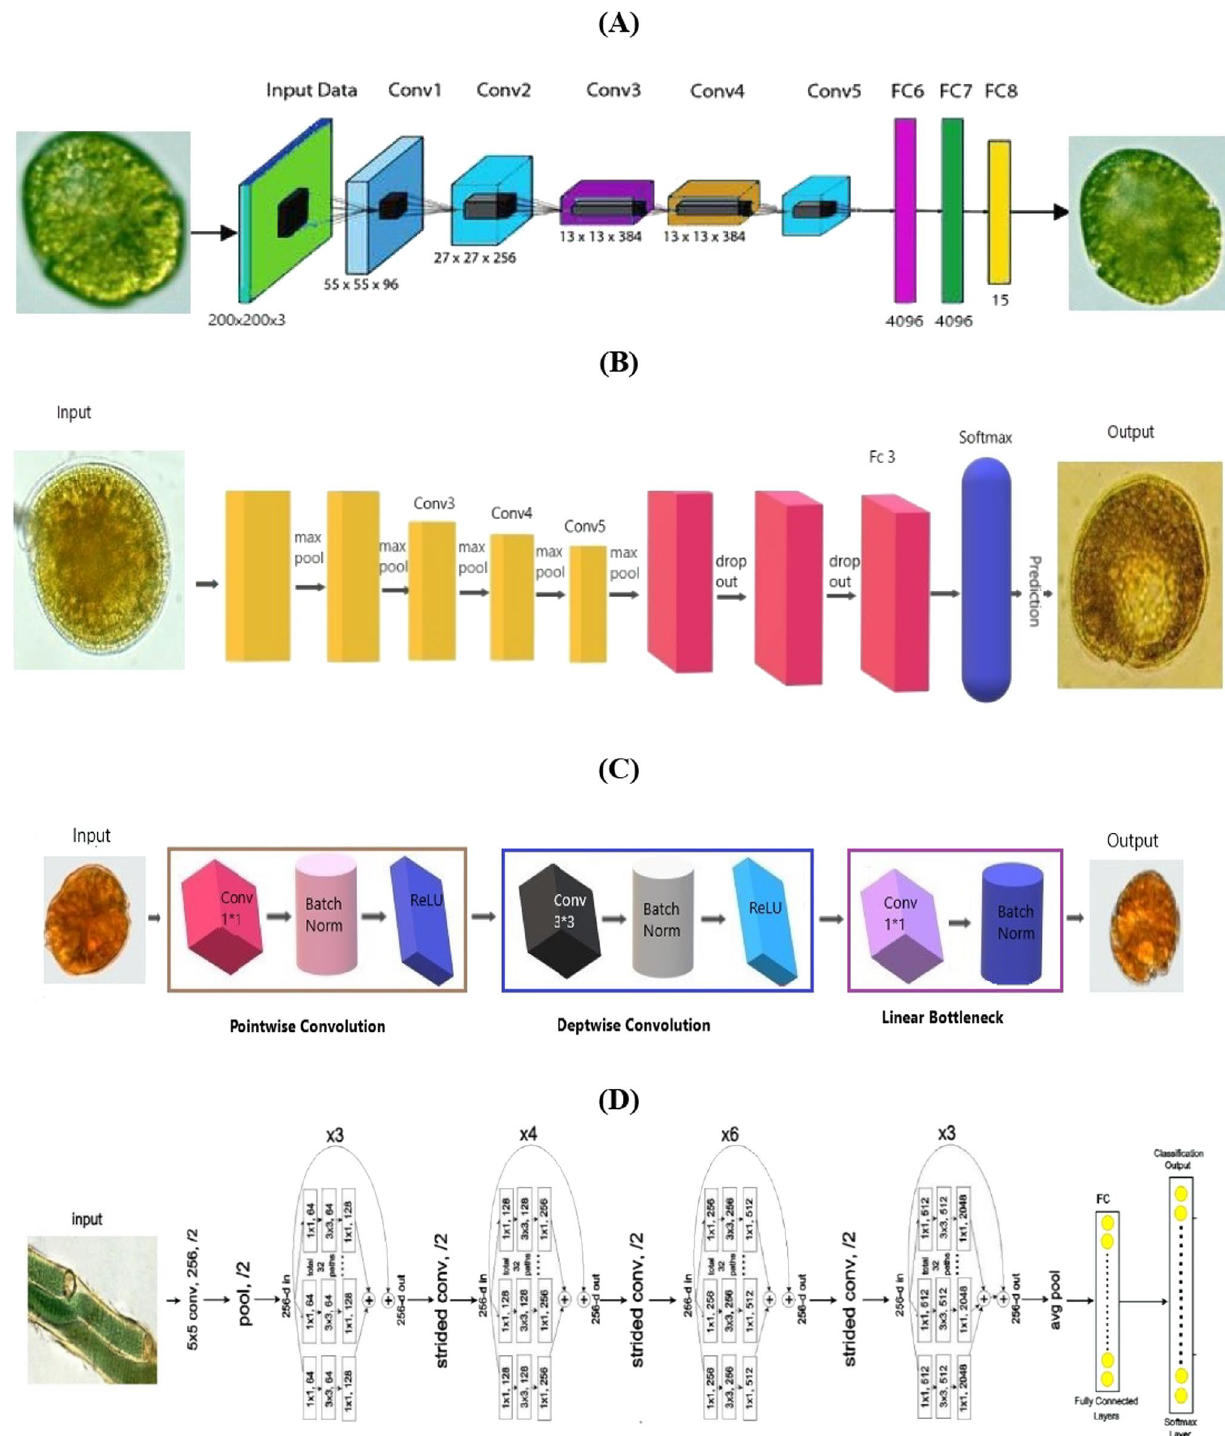
Fig. 1 Architecture for classification of bloom-forming algal images. A AlexNet, B VGG16, C MobileNetV2, and D Modified